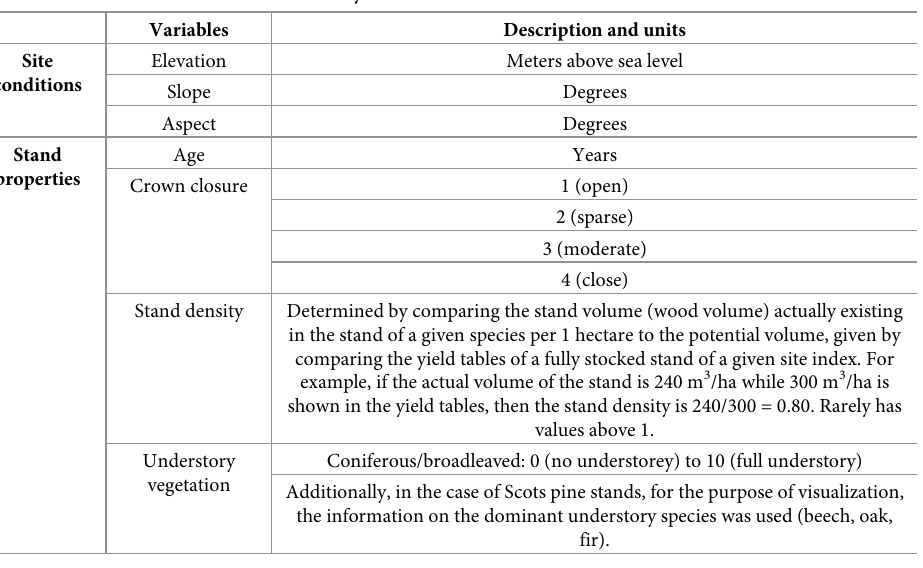
Table 1. Predictive variables used in this study.